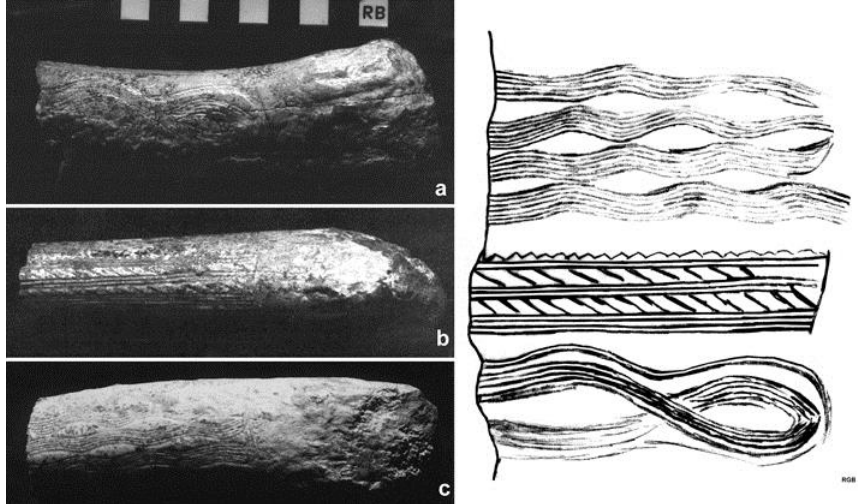
Figure 15. Three carefully engraved complex patterns and their rolled-off recording, on a 13,000-year-old deer’s antler fragment, from Longgu Cave, eastern